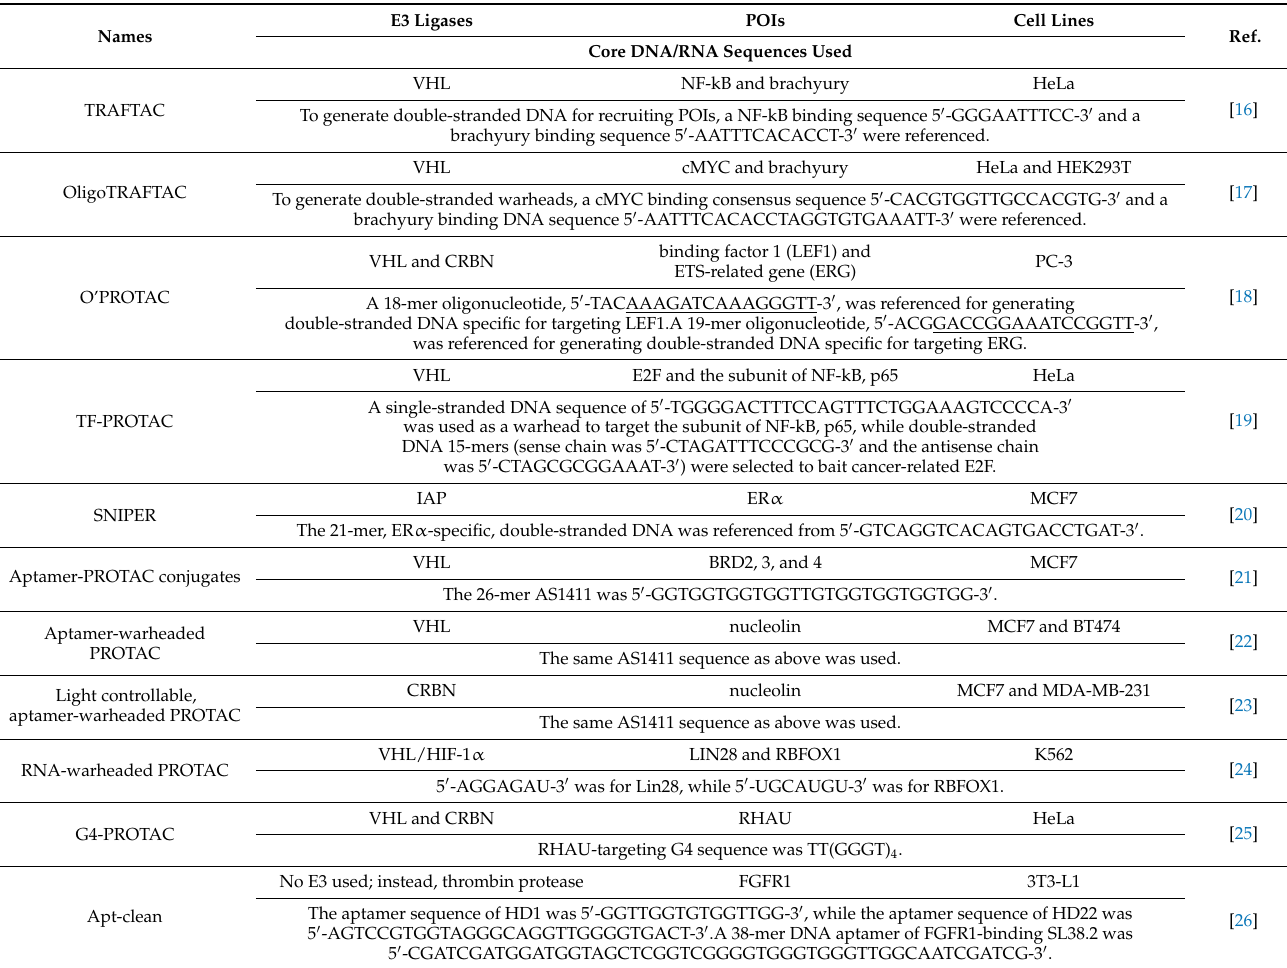
Table 1. Currently disclosed oligonucleotide-based degraders with the E3 ligase used, target proteins, cell lines tested, and core DNA/RNA sequences used. The DNA/RNA sequences may be extended or shortened, or the bases may be chemically modified. More information can be found in the corresponding